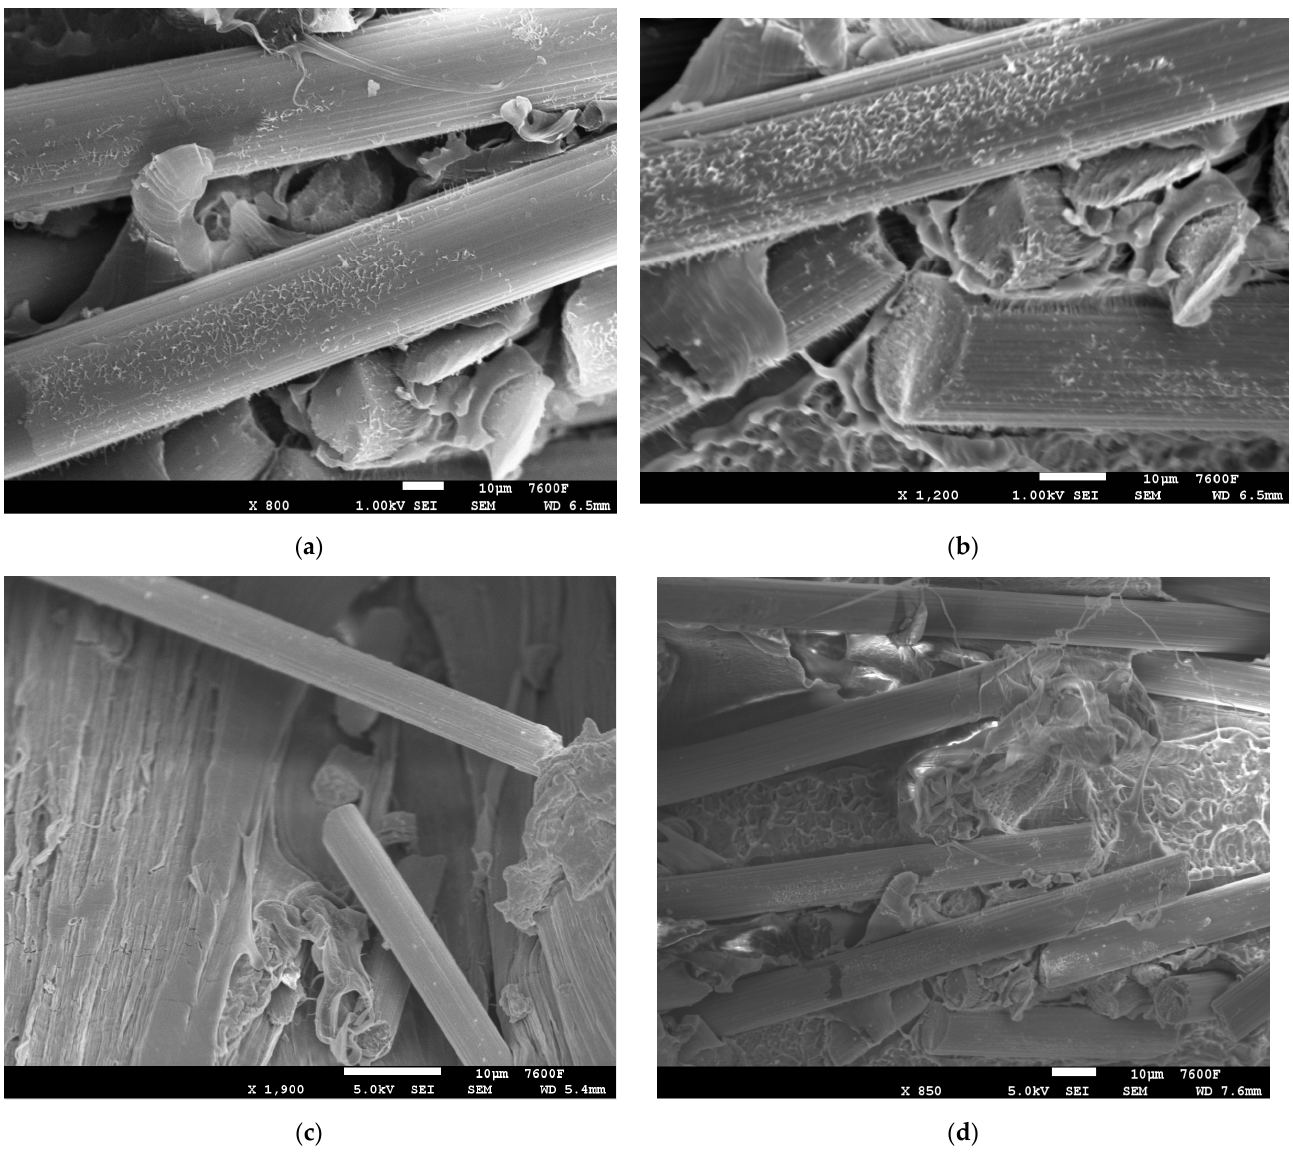
Figure 3. SEM images: ( a , b ) 10% CF/plasma PE, ( c ) 5% CF/plasma PE and ( d ) 15% CF/plasma PE combinations.